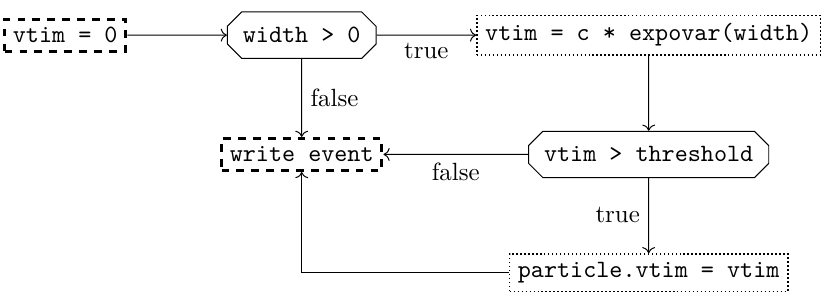
Figure 8 . The usual routine of MadGraph assigning the proper TOF ( vtim ) to a particle ( particle ) as long as it is larger than the threshold value ( threshold ) given in the run.card . The process flows from the node vtim = 0 to the node write event